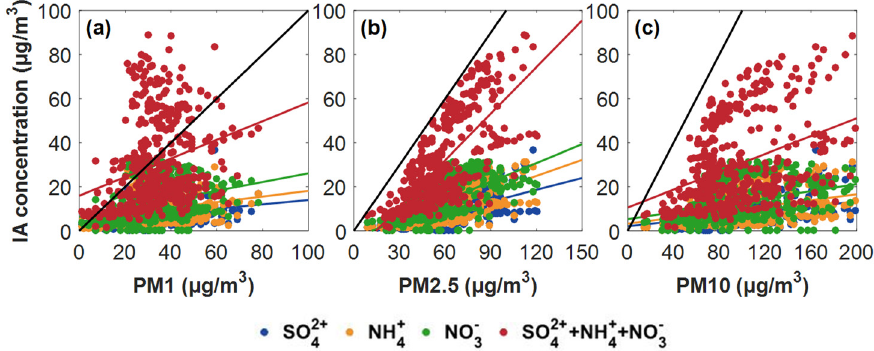
Figure 5. Correlation between secondary aerosol ions with ( a ) PM 1 , ( b ) PM 2.5 , and ( c ) PM 10 under wet conditions. The black lines represent the 1:1 reference lines.